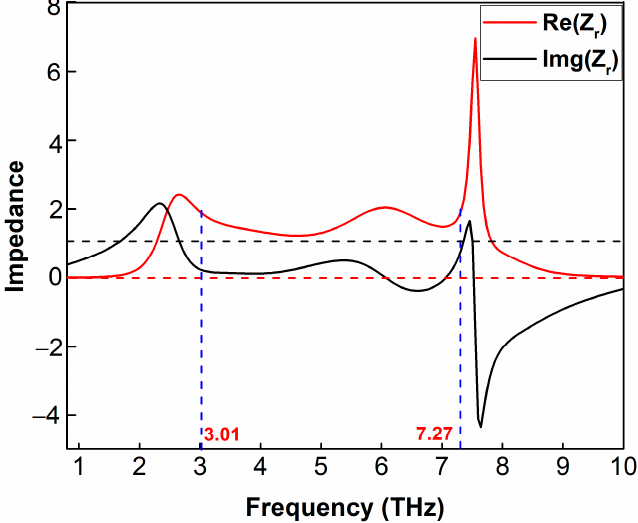
Figure 6. Relative impedance Z r diagram of the absorber at a conductivity of 2 × 10 5 S/m.